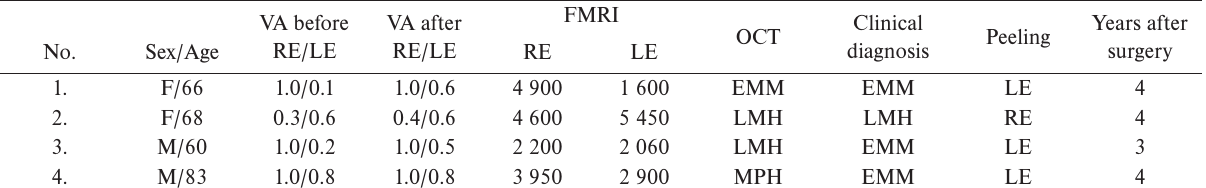
Table 1. Summary table of all patients.